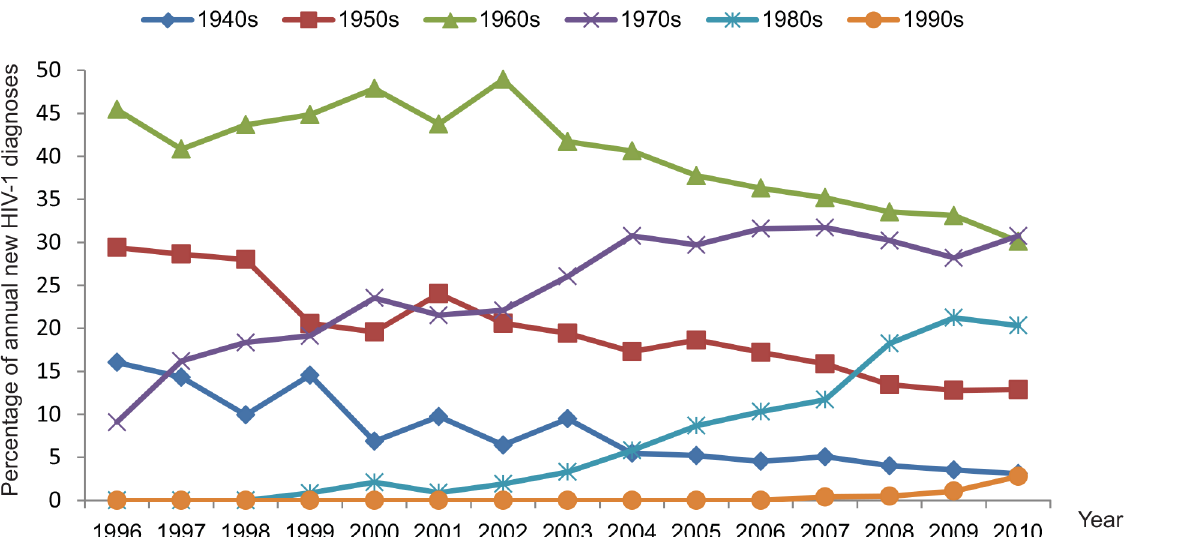
Fig 7. Proportional contribution of new HIV-1 diagnoses amongst all MSM in the ATHENA cohort by decade of